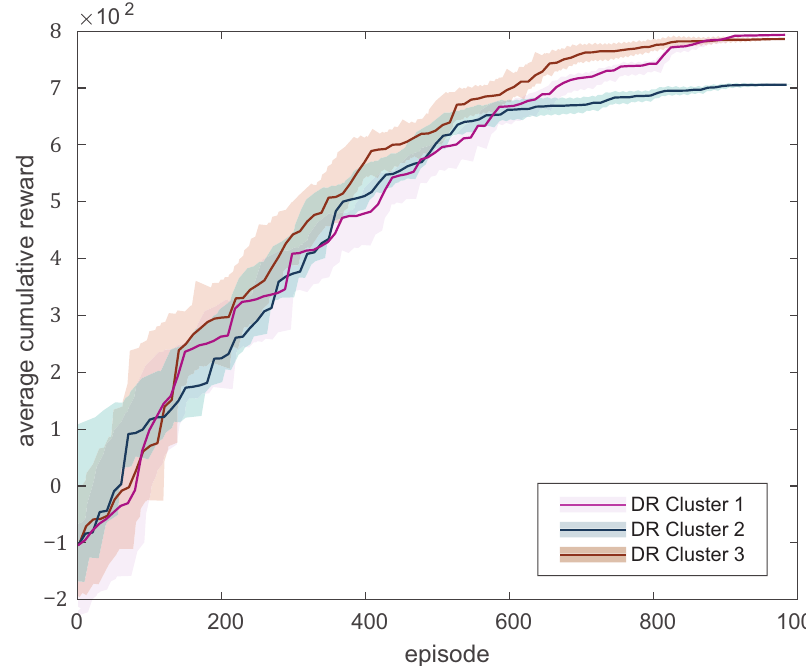
Figure 19. Average Cumulative Reward per